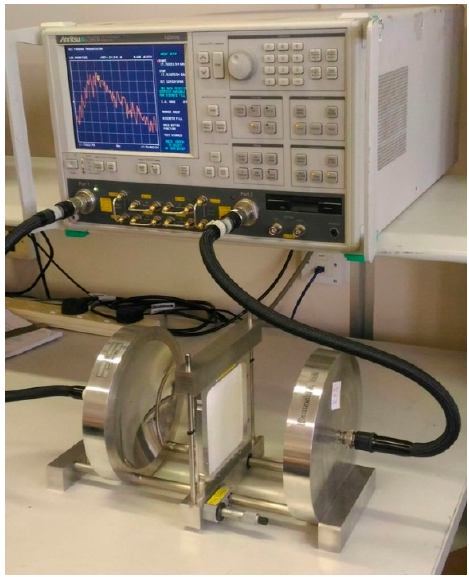
Figure 6. Damaskos model 600T open resonator with MUT in the center.